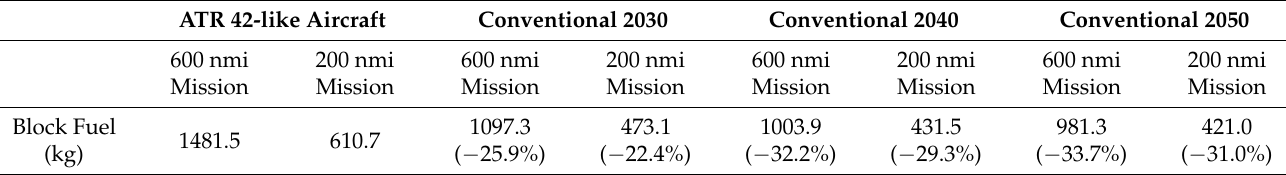
Table 7. Fuel consumed by the three conventional aircraft designed for the scenarios of GENESIS compared to the fuel consumed by today’s reference airplane, selected as similar to the ATR 42-600 model. All of the aircraft were designed and analyzed with